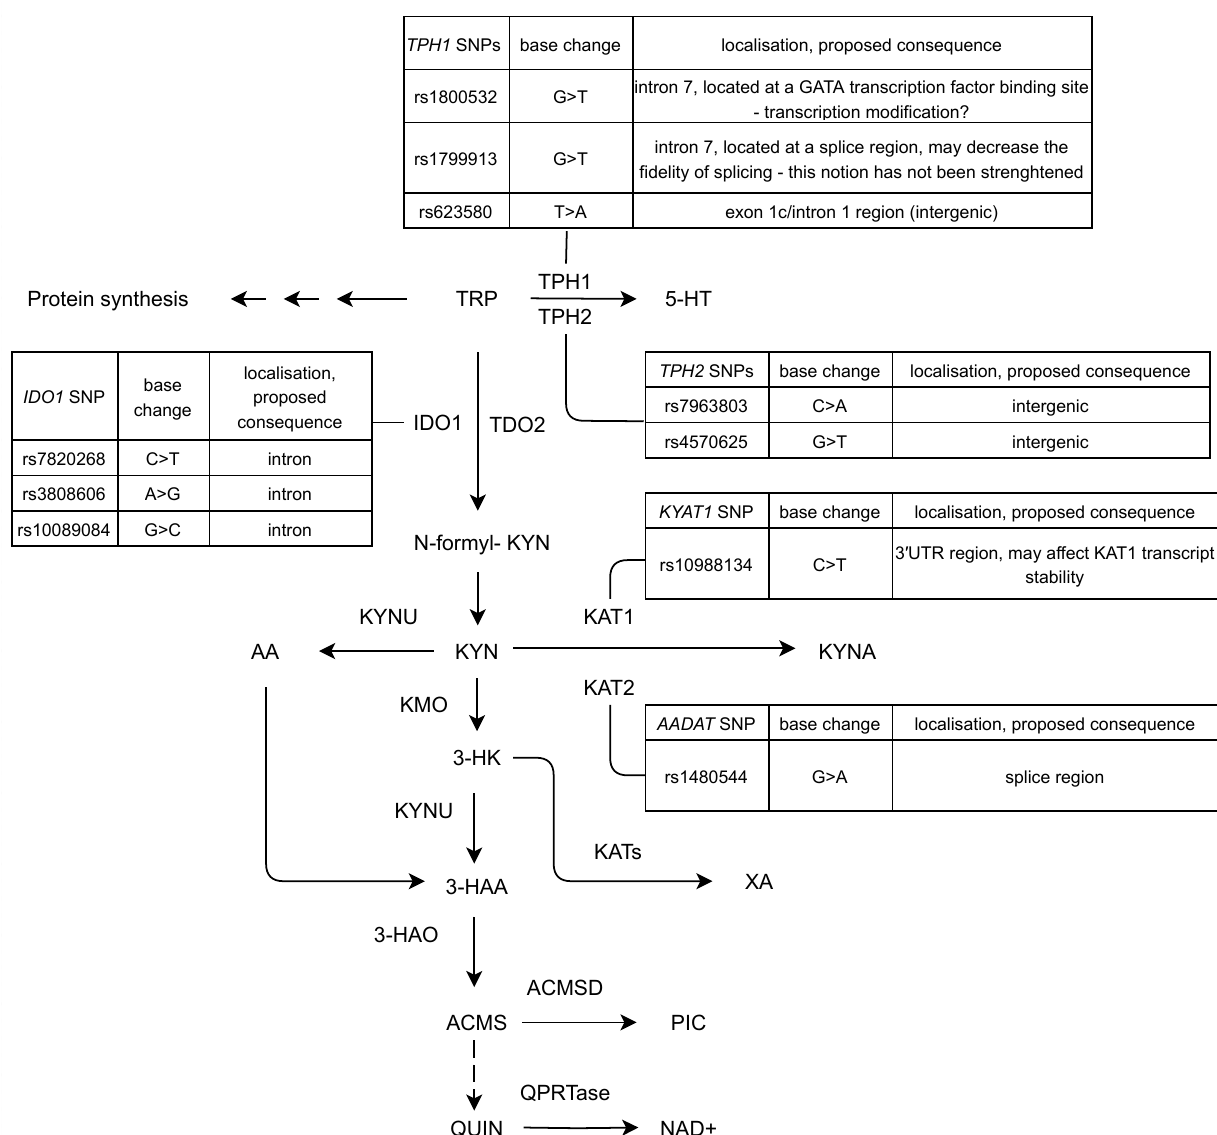
Figure 1. Schematic outline of Trp metabolism towards the production of serotonin and the kynurenine pathway. Enzymes and metabolites important in respect of this study are only shown by bold capital and capital abbreviations, respectively. The investigated variants of five genes included in this study are listed next to the corresponding gene. For references of SNP localisation and proposed consequences of the polymorphisms see Figures 2 and 3 and text.